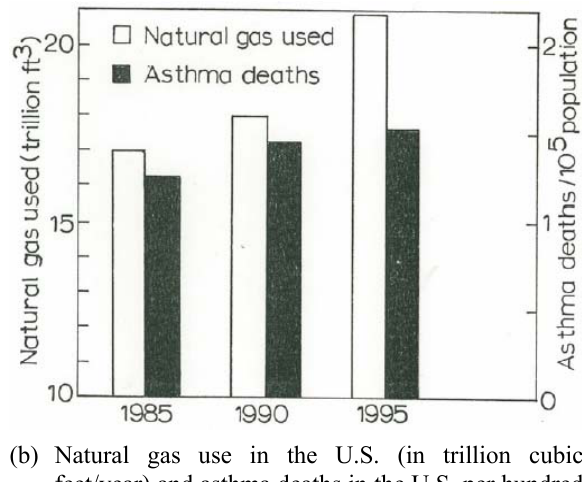
Figure 8: Asthma and Natural Gas Use . U.S. natural gas use data in (a) is from the U.S. Department of Energy, Energy Information Administration: http//www.eia.doe.gov/neic/infosheets/natgasconsumptio n.htm. The asthma data in (b) includes both male and female of all ages, age adjusted to the 1940 U.S. standard population; from the U.S. National Center